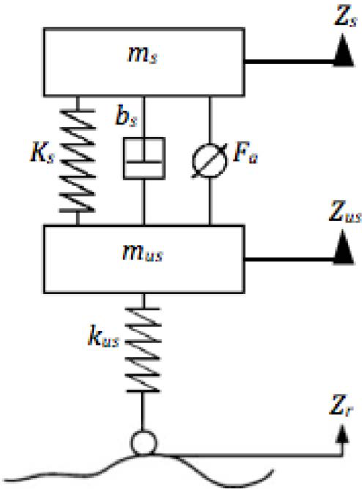
Figure 1. Quarter car model.